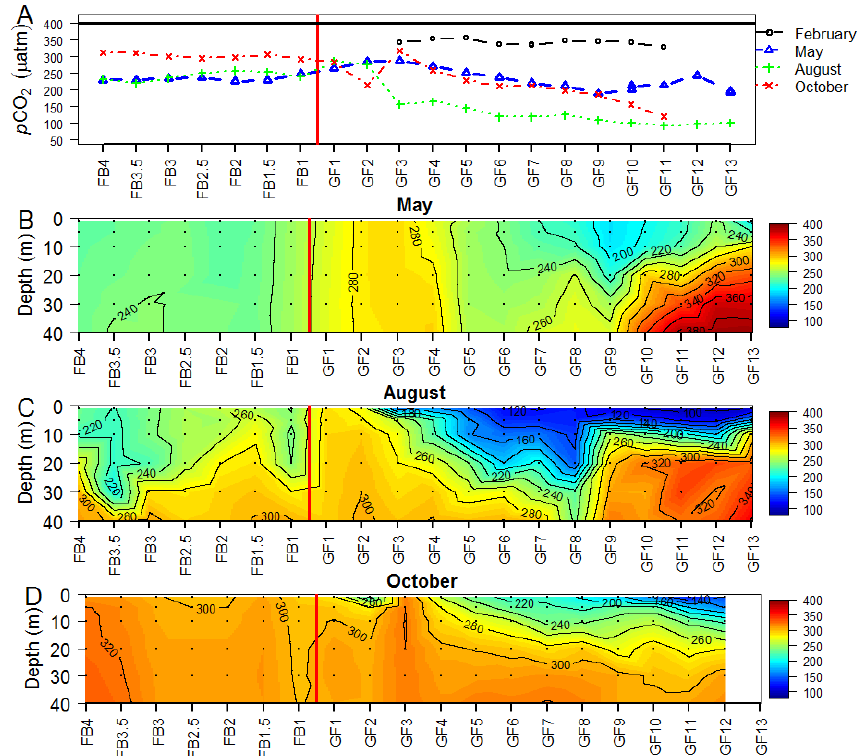
Figure 5. Partial CO 2 pressure data ( p CO 2 in µatm) at 1m depth for the four cruises (a) . The full line indicates the average atmospheric concentration (400µatm) measured during the year 2013. p CO 2 data for the May (b) , August (c) and October (d) cruise in the upper 40m water column from the shelf area (left) to glaciers (right). The red line indicates the mouth of the Godthåbsfjord